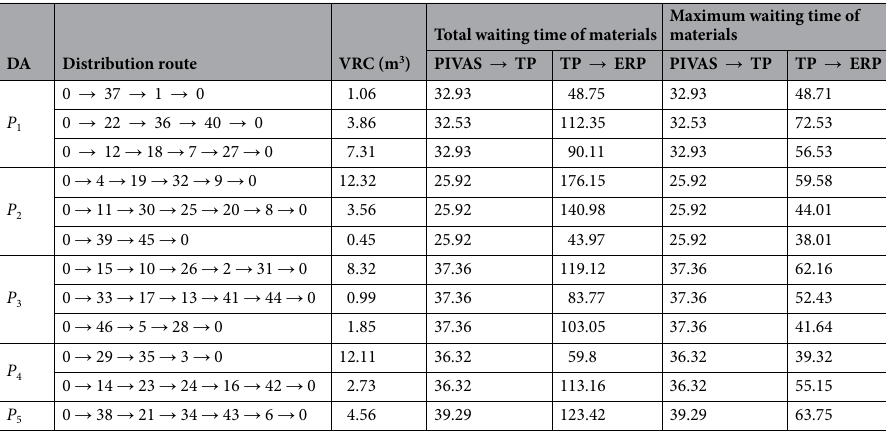
Table 3. Distribution route of transfer point based on DRO.